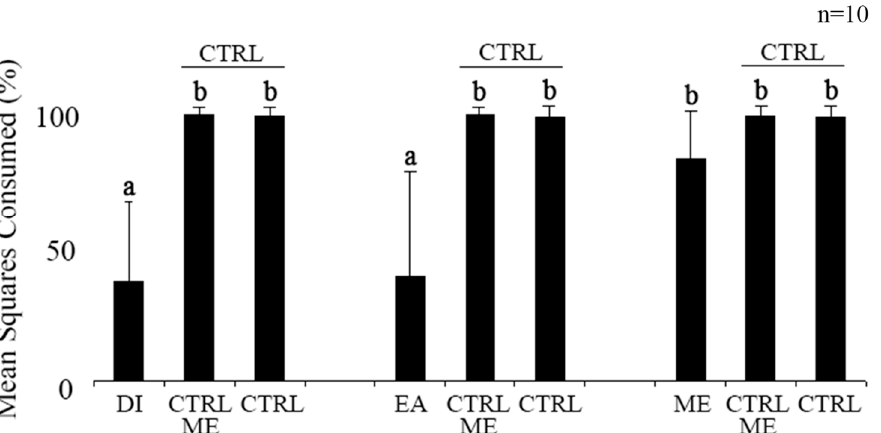
Figure 1. Effect of P. gymnospora extracts (dichloromethane DI, ethyl acetate EA and methanol ME) on the consumption by the sea urchin L. variegatus . Controls: CRTL, only grounded U. fasciata with solvent (CTRL ME) and without solvents (CTRL). Different letters above bars indicate distinct consumption ( p < 0.05). Values are means and standard deviation of n = 10.